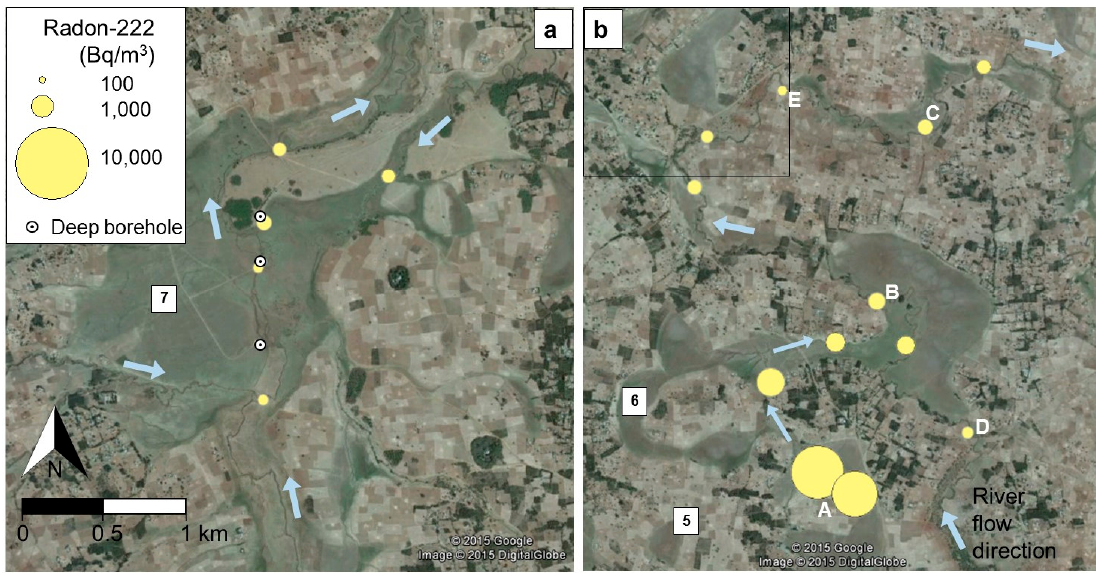
Figure 8. (a) Radon-222 measurement locations and results showing evaluation of impact of deep (150 and 192 m) abstracting boreholes on surface water and shallow groundwater; (b) Radon-222 measurement locations and results showing 222 Rn concentration variation with distance along surface flow path from source (location A). Note the elevated concentrations in broad dambo floodplains (locations B and C) in comparison to narrow valley samples (locations D and E). Locations 5–7 are referred to in the text. The black box shows the location in Figure 7a (which extends to the north).